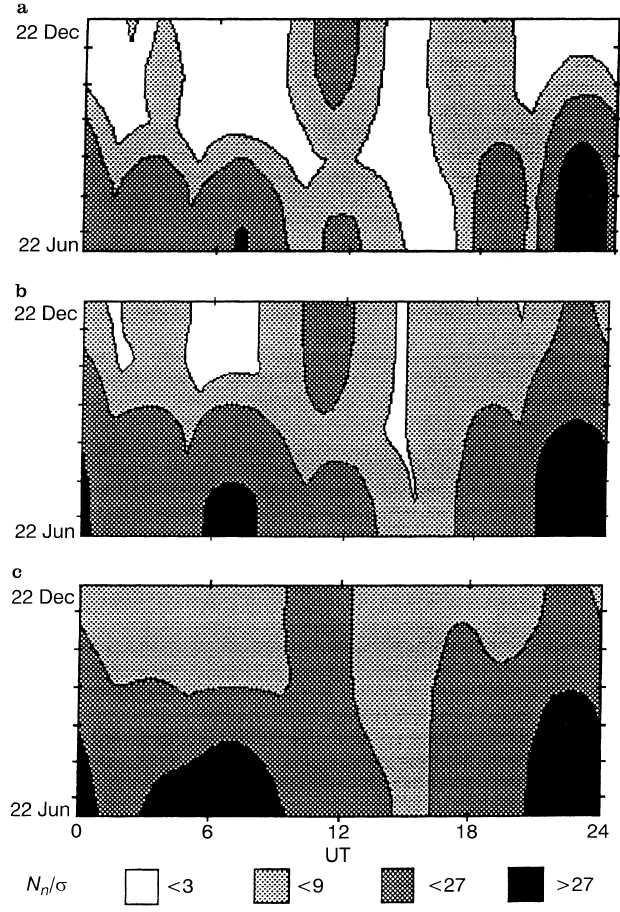
Fig. 2a-c. The sensitivity of the World Neutron Monitor Network to an intense solar-neutron event comparable to that of 3 June 1982 as a function of time of occurrence of the event. The shadowing corresponds to the significance of the detection of the event, in terms of N n = (cid:114) . a The network sensitivity according to Eq. (5); b The network sensitivity according to Eq. (6); c The network sensitivity when the weighted summation of responses